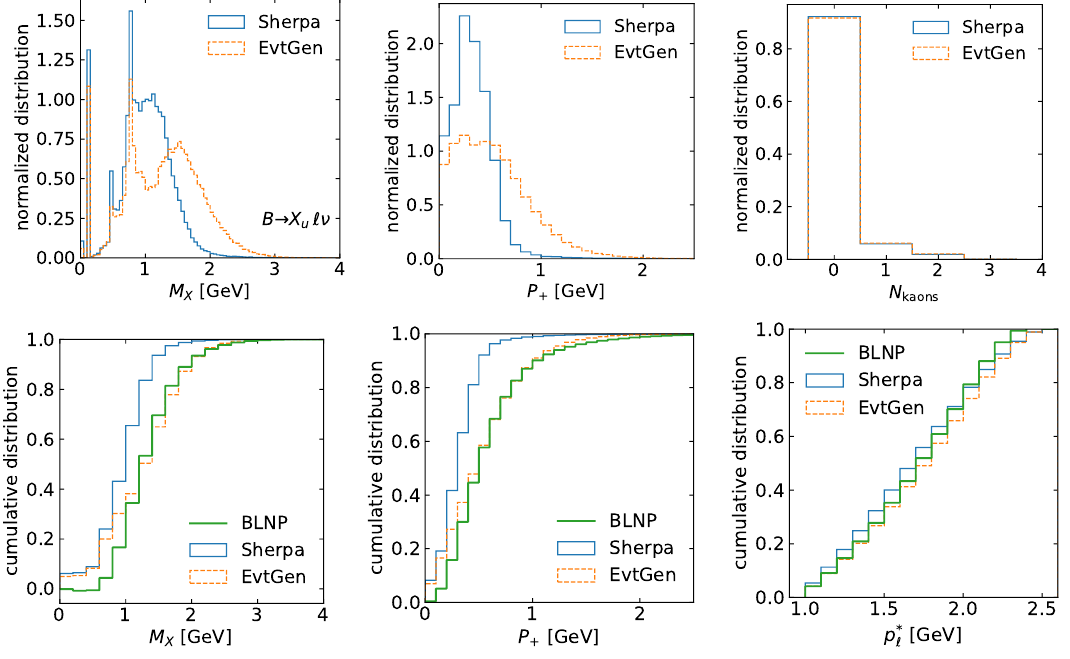
Figure 3 . Upper panel: comparison of E VT G EN and S HERPA high-level features for B → X u ‘ν signal events. Lower panel: cumulative sum of the differential distributions M E VT G EN and S HERPA , compared to BLNP